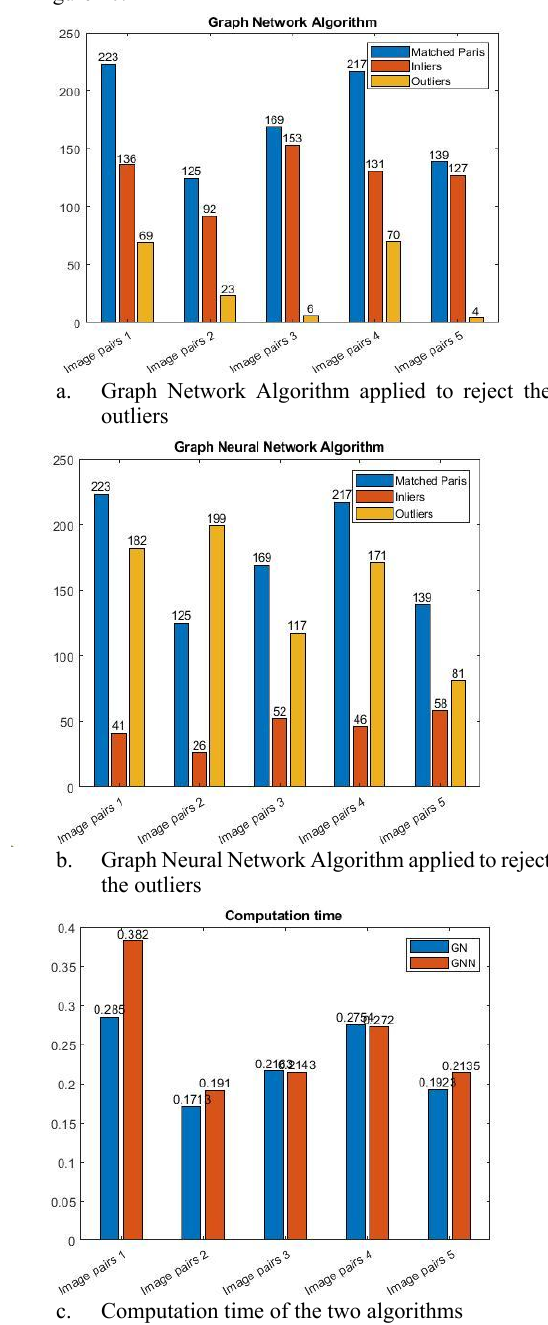
Figure 10: Applying the algorithms to image pairs